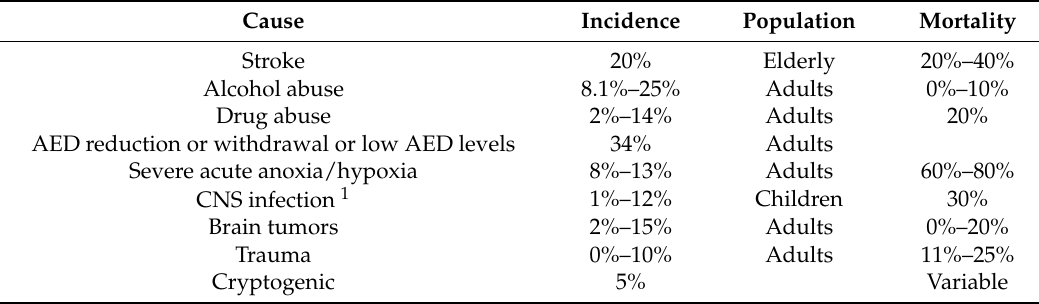
Table 1. Frequency and prognosis of status epilepticus of different